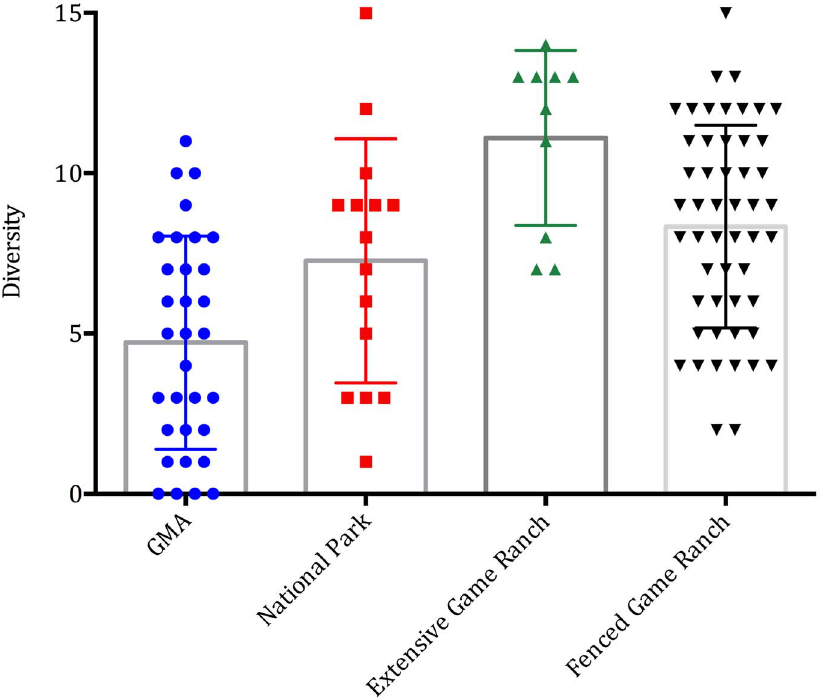
Figure 4. The diversity of wild ungulates (excluding species of bushbuck size and smaller and hippos, for which data were unavailable for state protected areas) include small plots as well as actual ranches).